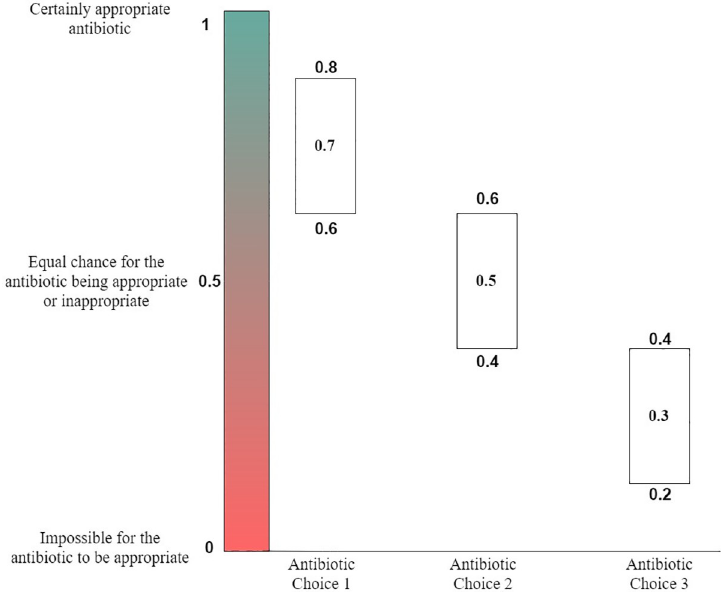
Fig 4. Example of how to estimate appropriateness of antibiotic choices. Antibiotic choices (single or multiple agents) are classified as appropriate or inappropriate. This is achieved by utilizing the Bayesian WISCA value for each choice. A threshold of 0.5 for the Bayesian WISCA value was selected. An antibiotic choice with a Bayesian WISCA value greater than 0.5 means that the chance of coverage exceeds the chance of not providing coverage. The interquartile range of the Bayesian WISCA was used to determine the appropriate antibiotics. This helped in accounting for the uncertainty level of each antibiotic choice to classify as appropriate or not. In the examples given antibiotic choice 1 has a mean Bayesian WISCA of 0.7 and 1st IQR value is 0.6. Since all simulated outcomes with this choice remain above 0.5 it is classified as appropriate. The second antibiotic choice presented has an IQR extending below 0.5 and despite a mean Bayesian WISCA of 0.5 is determined to be equivocal. The third antibiotic choice is classified as inappropriate since all the IQR values is below 0.5.